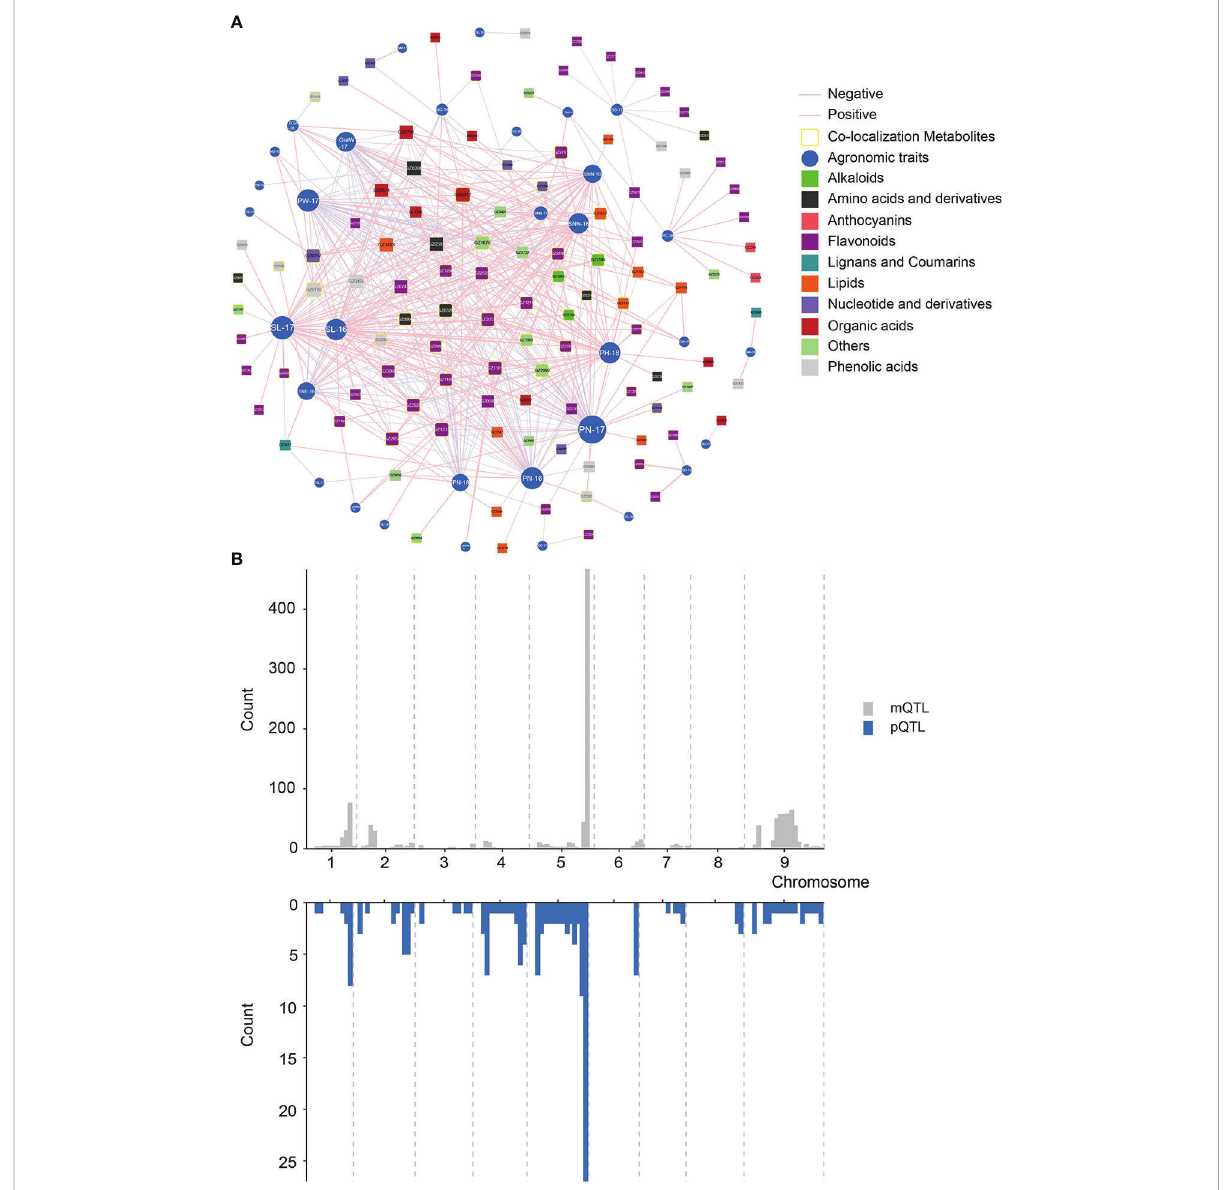
FIGURE 5 Association network visualization of metabolite-agronomic traits and co-localized anaysis. (A) Association analysis of 381 annotated metabolites with agronomic traits. Metabolites and agronomic traits are represented as nodes, and their correlation coef fi cient values as edges.The absolute values of the Pearson ’ s correlation coef fi cient values above the threshold (P < 0.01) are shown. Different colours represent different classes of metabolites. Green rectangles and blue circles are represented as metabolites and agronomic traits, respectively, where the size of the shape represents the number of associations. The level of correlation is indicated as red (positive correlation) or blue (negative correlation). The intensity of the colour indicates the correlation, where a darker colour denotes a stronger correlation. The yellow circles indicate metabolites that are signi fi cantly associated with the co-localization of close agronomic traits. (B) Co-localization analysis between metabolites and agronomic